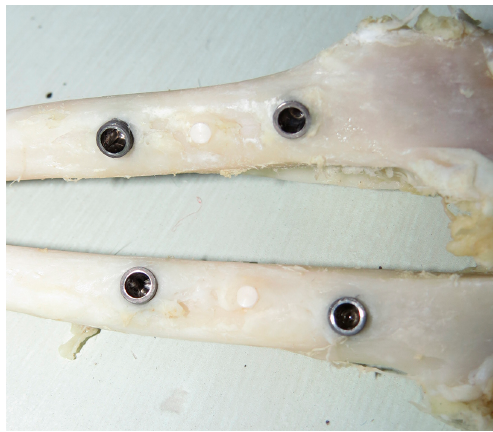
Figure 5. Representative image of both tibias after the soft tissue was retrieved and removed.